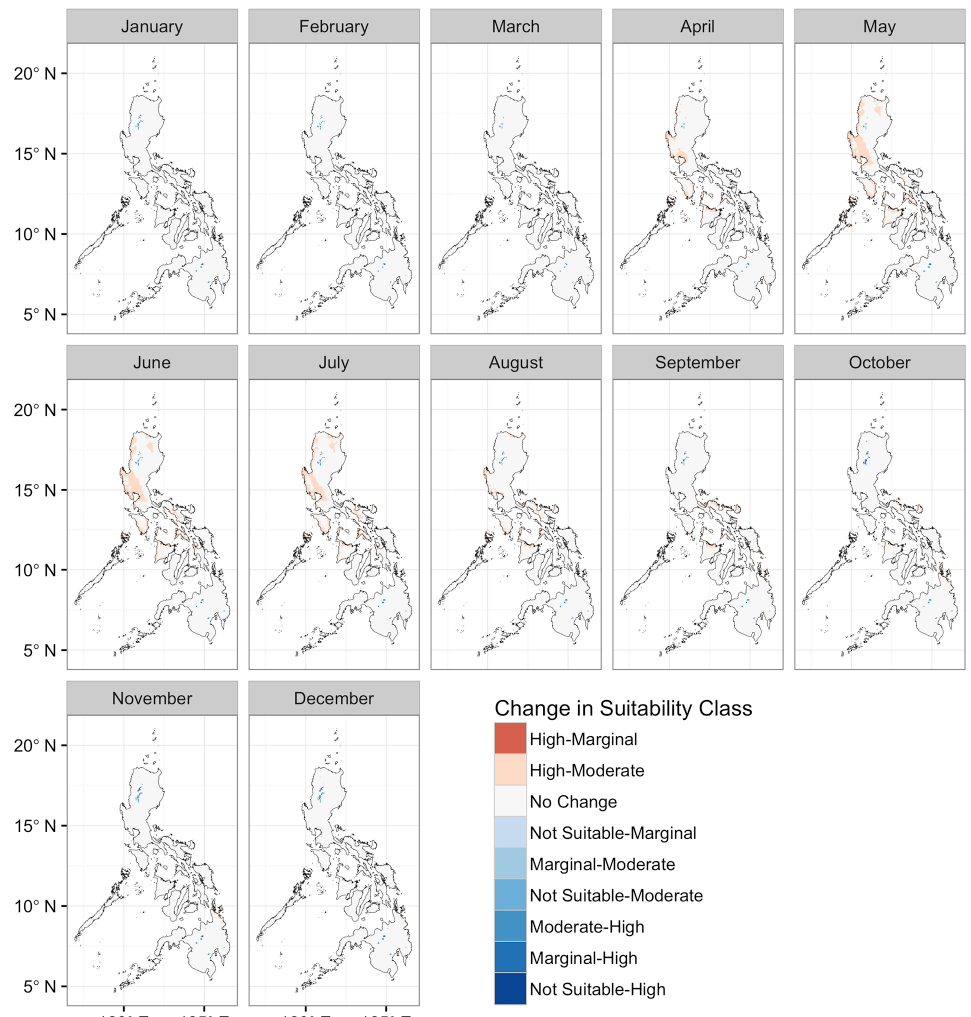
Fig. 11. Monthly spatial distribution of changes in climatic suitability of corn based on temperature in the Philippines under future climate